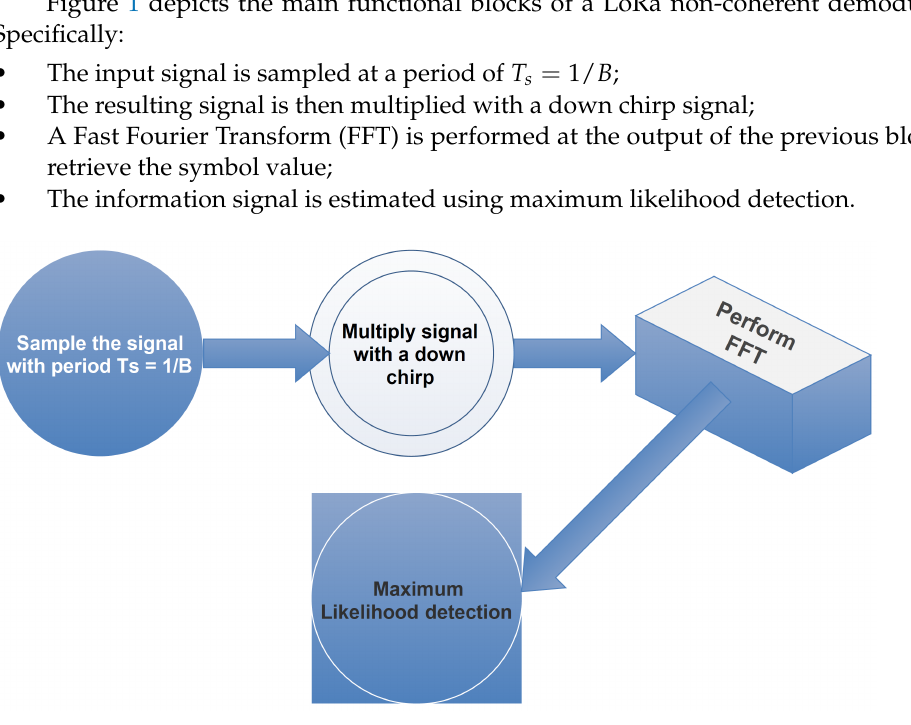
Figure 1. A simplified overview of the LoRa non-coherent